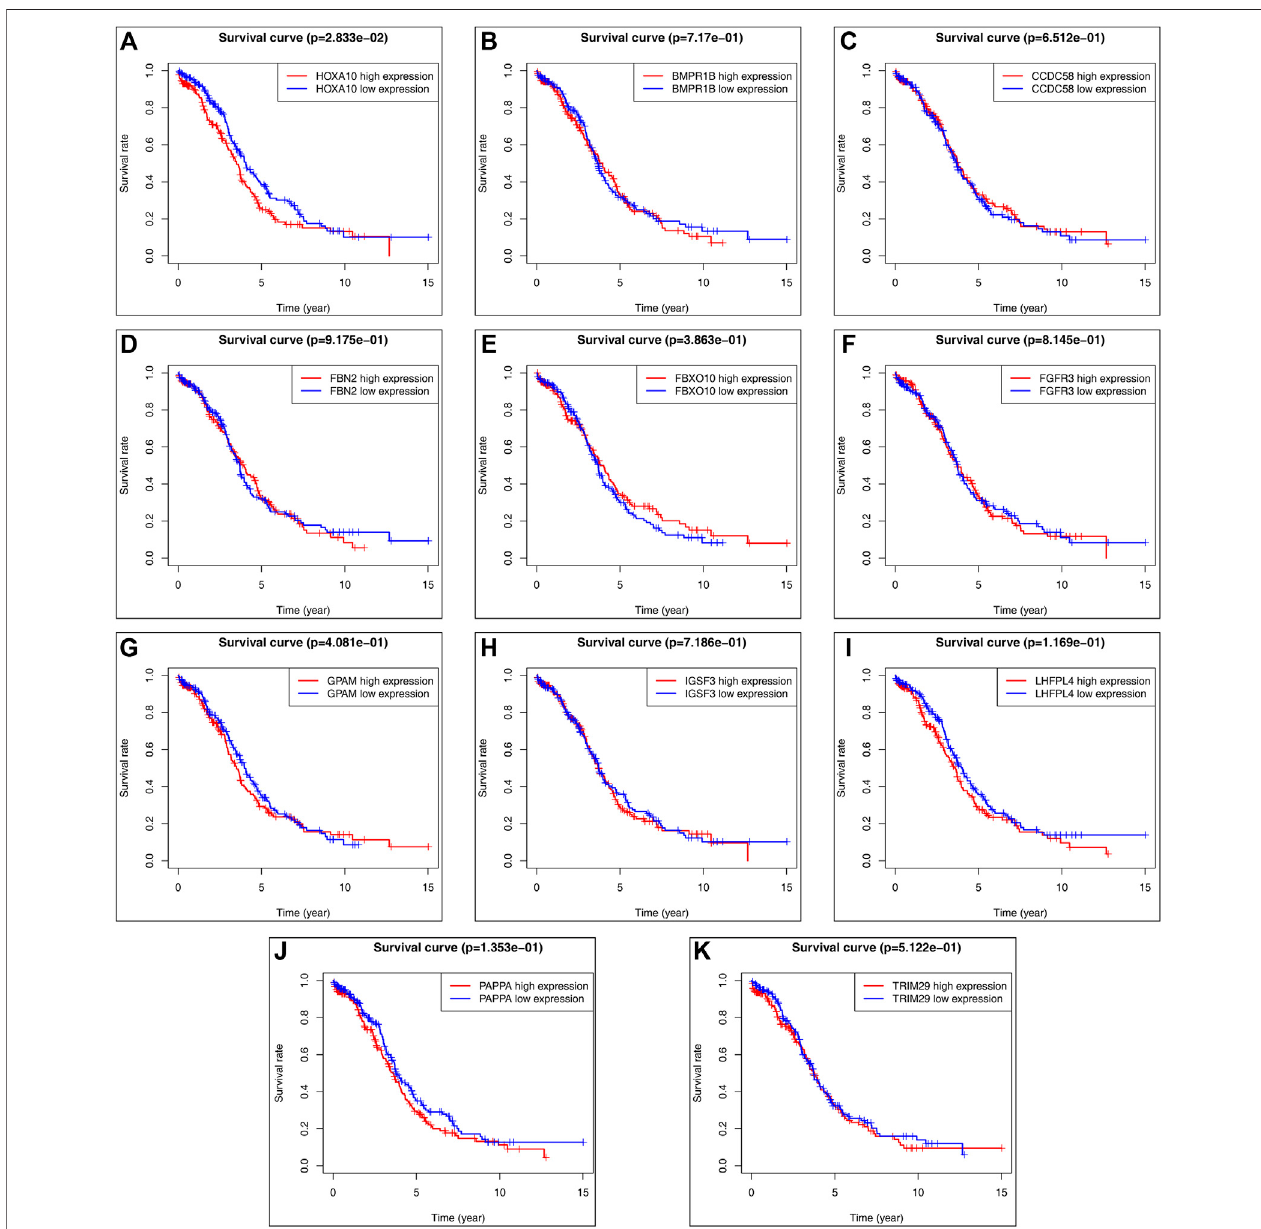
FIGURE 6 | Predicted target gene survival curve: (A) HOXA10 gene survival curve. (B) BMPR1B gene survival curve. (C) CCDC58 gene survival curve. (D) FBN2 gene survival curve. (E) FBXO10 gene survival curve. (F) FGFR3 gene survival curve. (G) GPAM gene survival curve. (H) IGSF3 gene survival curve. (I) LHFPL4 gene survival curve. (J) PAPPA gene survival curve. (K) TRIM29 gene survival curve. (The red curve indicates high gene expression, the blue curve indicates low gene espression).